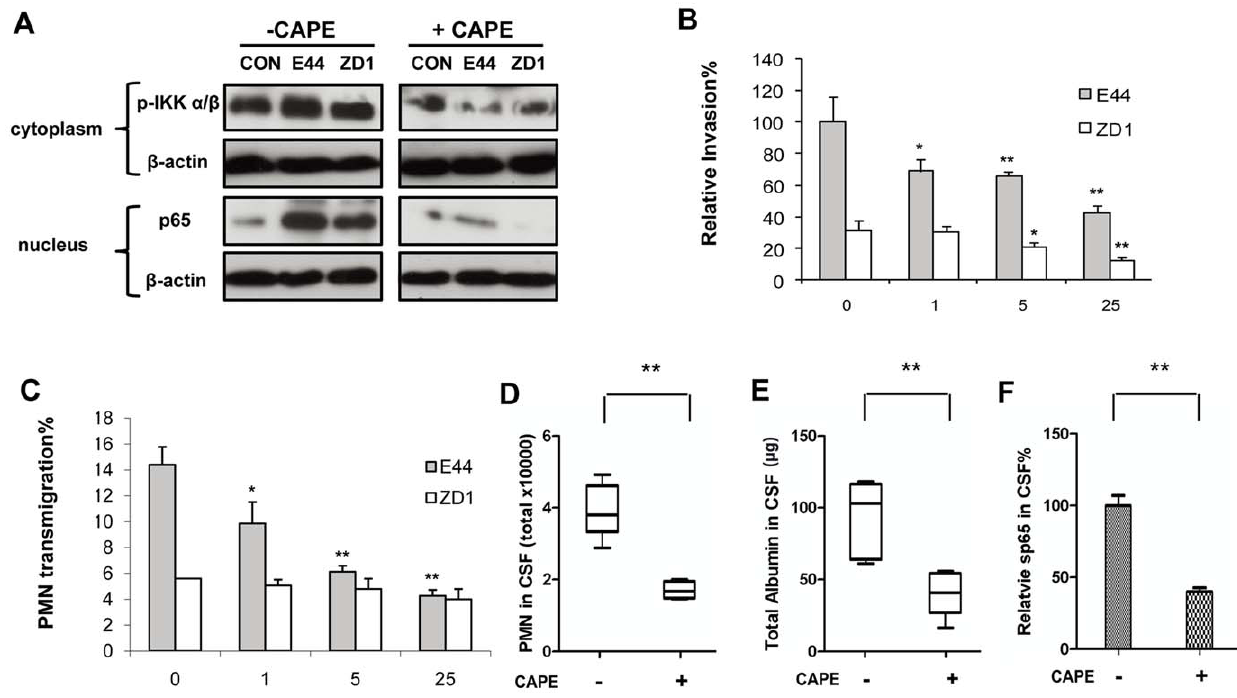
Figure 1. Effects of CAPE on IbeA + E.coli K1-induced NF- k B activation and pathogenicities invitro and invivo . ( A ) IbeA + E. coli K1 induced NF- k B activation in HBMECs was suppressed by CAPE. HBMECs were incubated with or without the NF- k B inhibitor CAPE (25 m M) for 30 min before stimulation with E44 or ZD1 (10 7 /mL). IKK a / b phosphorylation (p-IKK a / b ) in cytoplasmic fractions and NF- k B (p65) in nuclear fractions was examined after 2 h of stimulation with E. coli strains. The b -actin in both fractions was detected as internal loading controls. CON, control without E. coli stimulation. ( B–C ) Effects of CAPE (0–25 m M) on IbeA + E. coli K1 penetration and PMN transmigration across HBMECs were examined. HBMECs were incubated with various concentrations of CAPE for 1 h before the invasion and PMN transmigration assays. ( B ). E. coli (10 7 CFU) were added